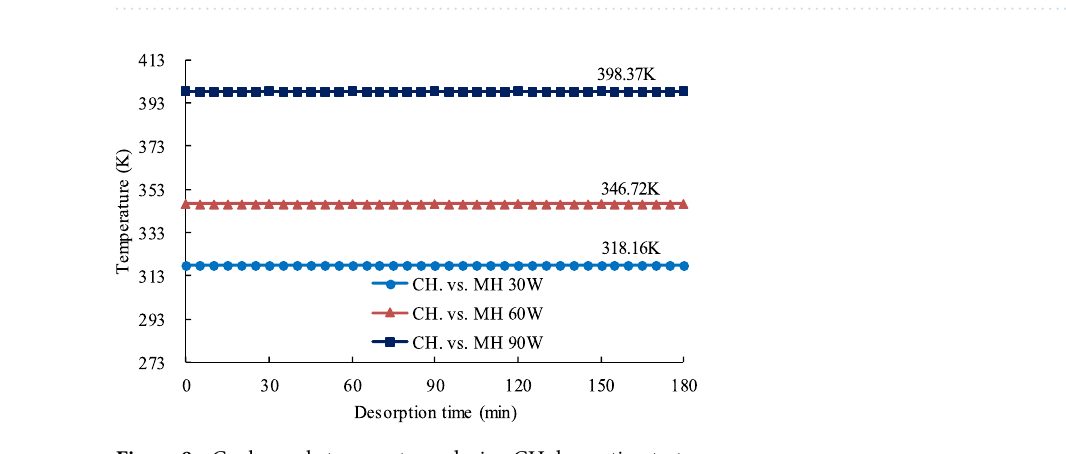
Figure 7. Graph showing temperature vs. time for the coal samples during the three MH desorption tests.